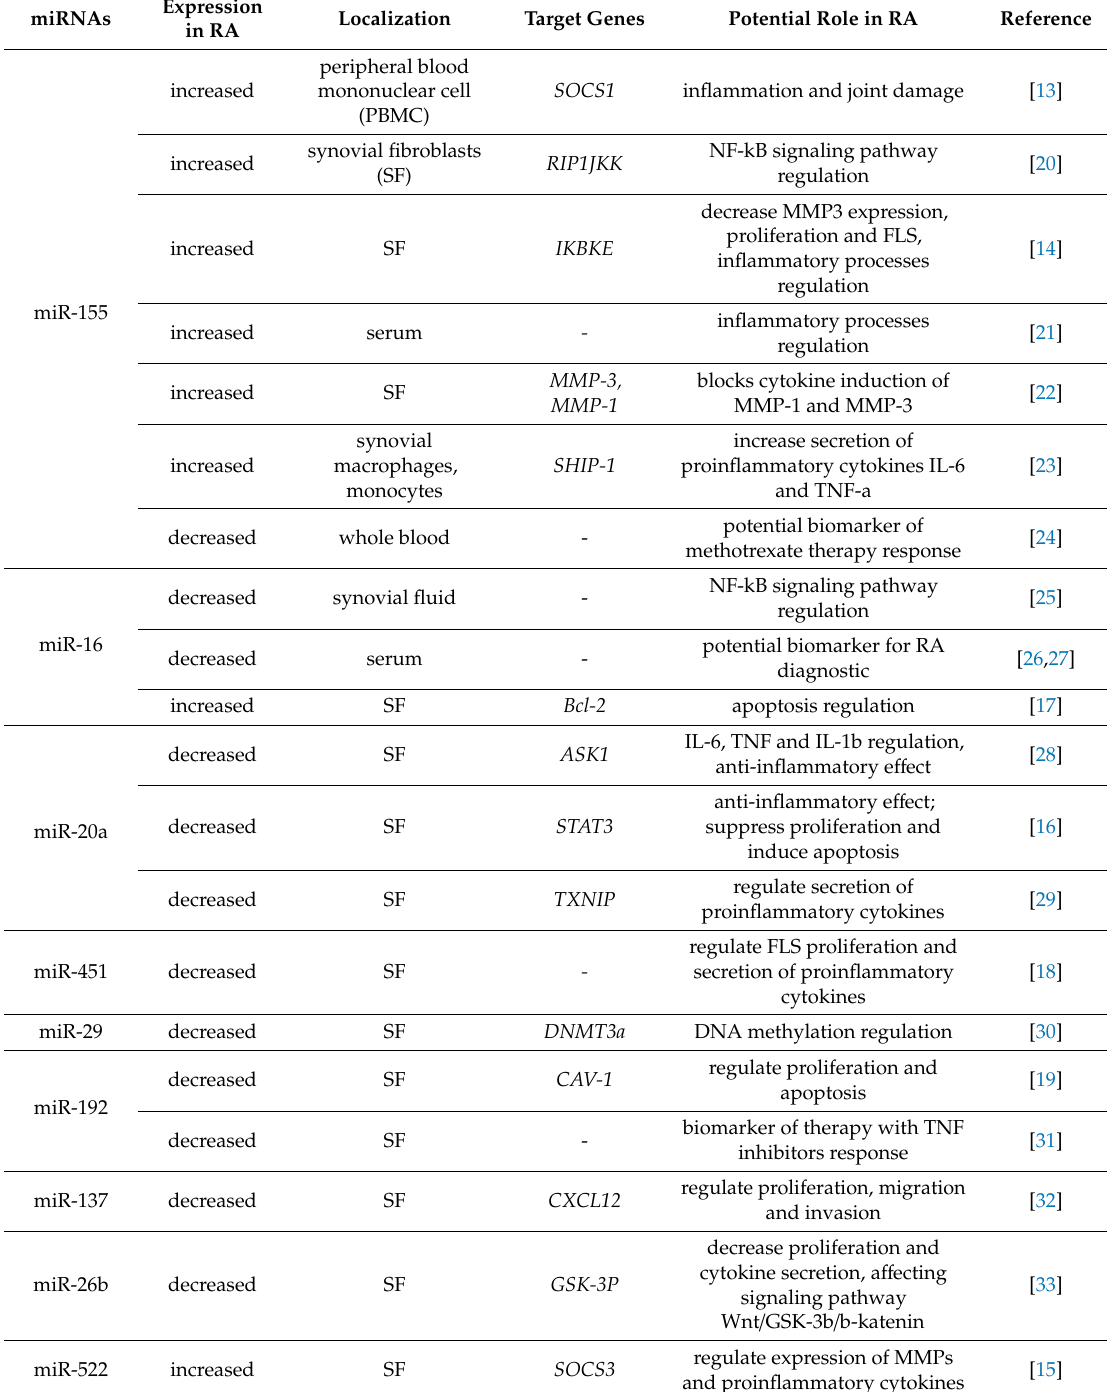
Table 6. MiRNAs included in the study and their role in